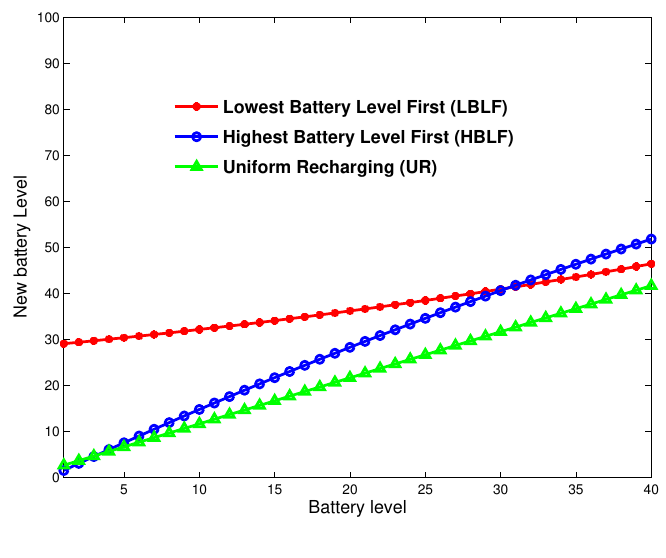
Figure 6. Scheduling